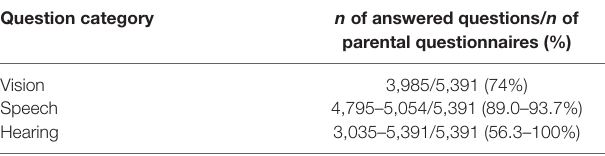
TaBle 3 | Parental questionnaire response percentage. Question category